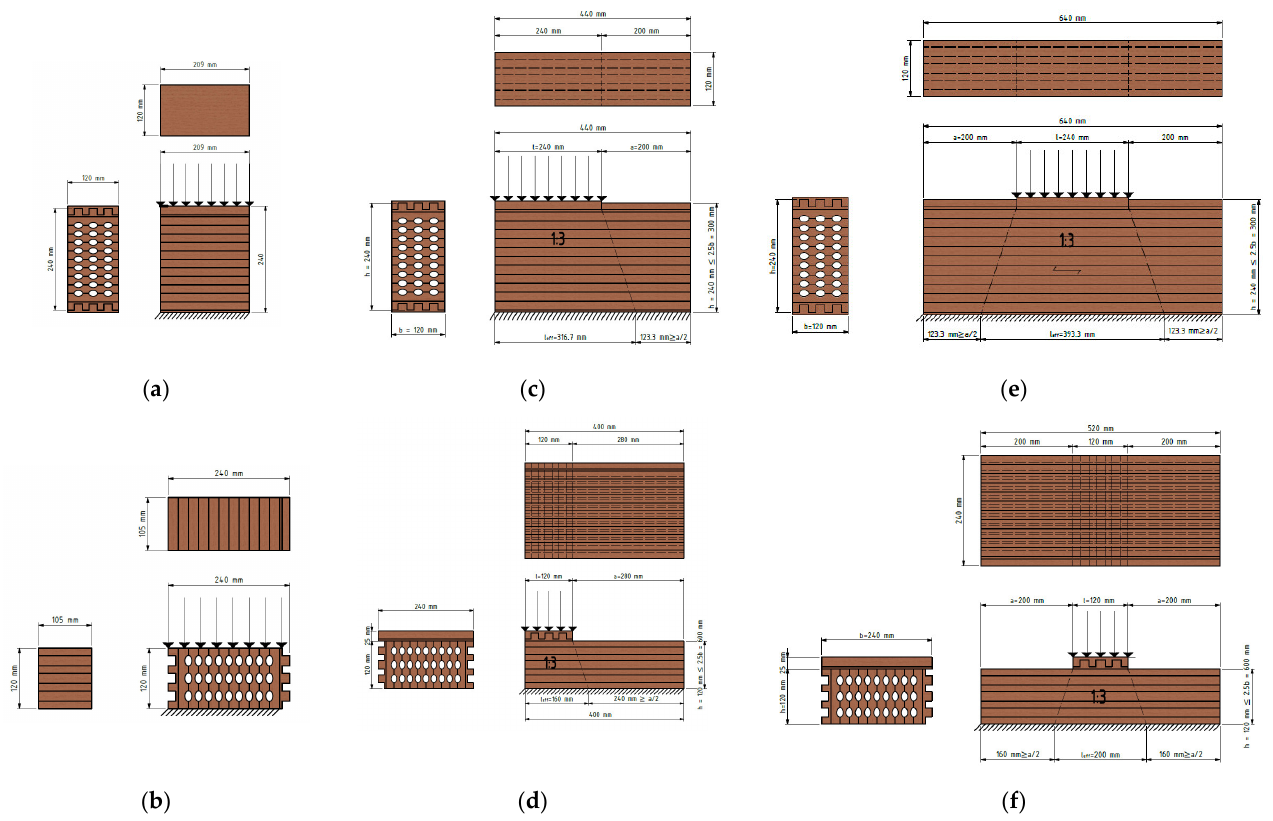
Figure 6. Positioning and loading of specimens, considering the axis direction and boundary con- ditions: ( a ) Specimen loaded over the entire surface in the strong-axis direction (four groups); ( b ) specimen loaded over the entire surface in the weak-axis direction (four groups); ( c ) specimen loaded on the edge in the strong-axis direction (three groups); ( d ) specimen loaded on the edge in the weak-axis direction (three groups); ( e ) specimen loaded in the middle area in the strong-axis direction (three groups); ( f ) specimen loaded in the middle area in the weak-axis direction (three groups). While the hollow timber elements can be seen in the image above, the full normal ones are the same, but completely without the elliptical holes. As it can be seen in Figure 5,